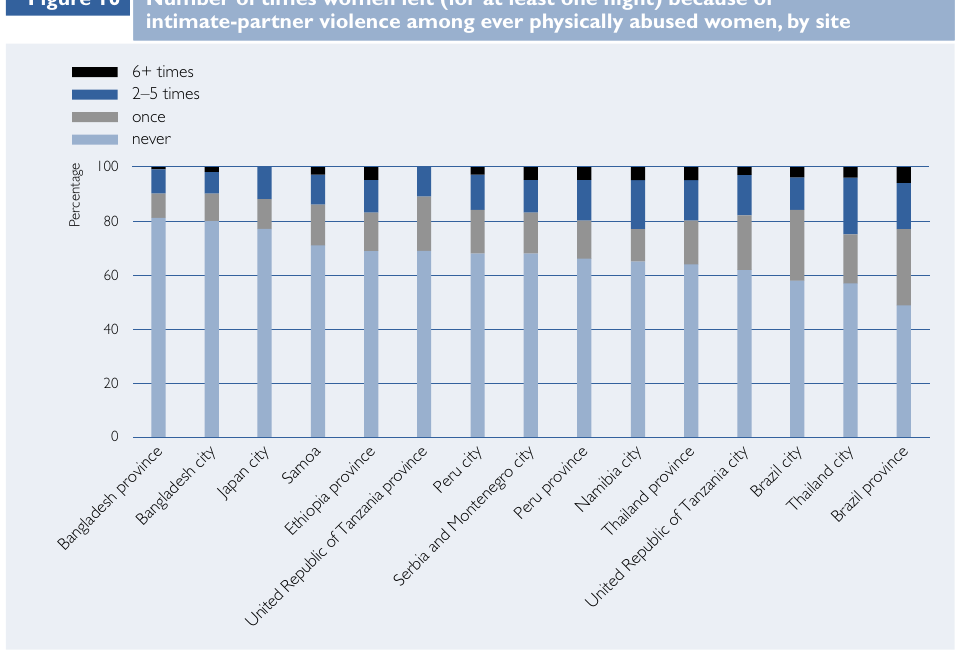
Number of times women left (for at least one night) because of intimate-partner violence among ever physically abused women, by